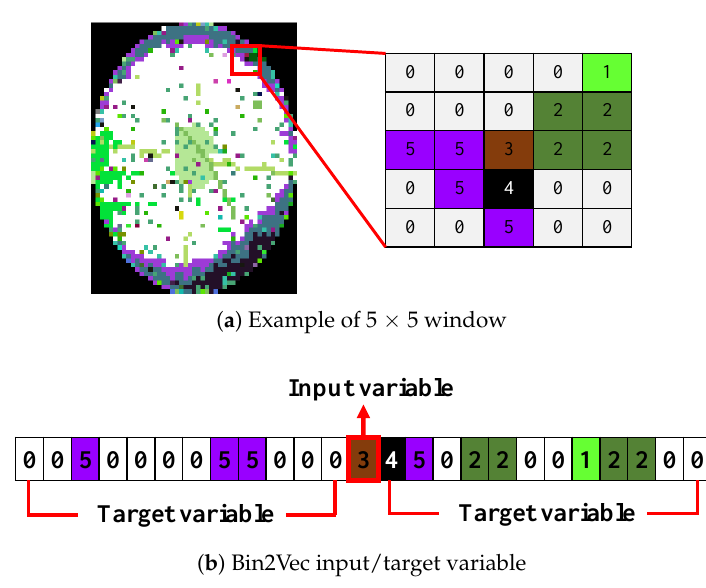
Figure 5. Data converted from WBM to Bin2Vec input structure.